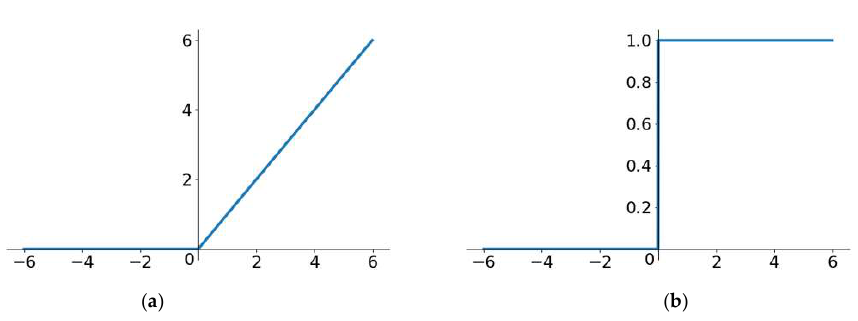
Figure 7. The graph of ReLU: ( a ) is the graph of the ReLU function; ( b ) is the derivative graph of the ReLU function.